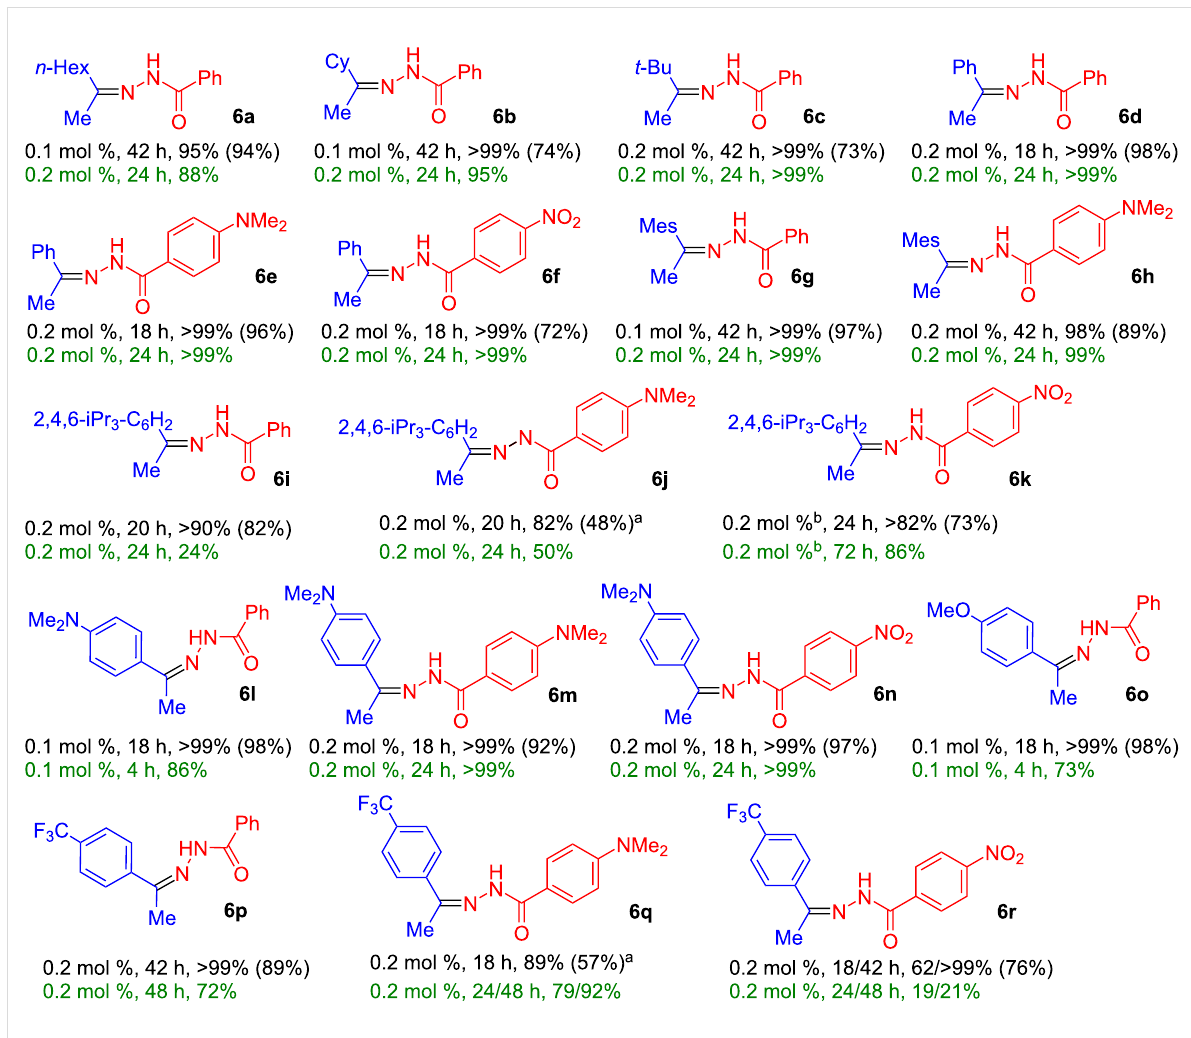
Scheme 3: Hydrohydrazidation of terminal alkynes in chlorobenzene and anisole using complex 1 (first line solvent chlorobenzene, second line sol- vent anisole: catalyst loading, reaction time, conversion % (isolated yield %), reaction temperature 60 °C). a Partial decomposition during column